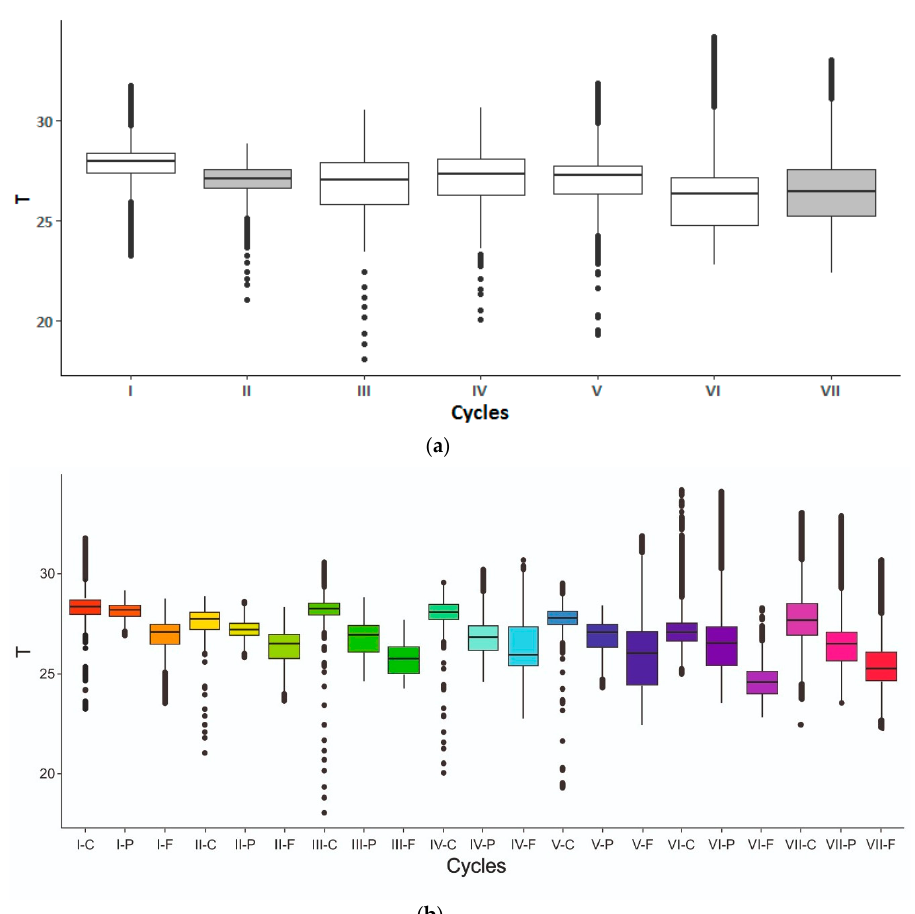
Figure 4. Average temperatures in the animal zone (T) for ( a ) each cycle and ( b ) each of the critical (C), postcritical (P) and final (F) periods. The same colour suggests equal averages.